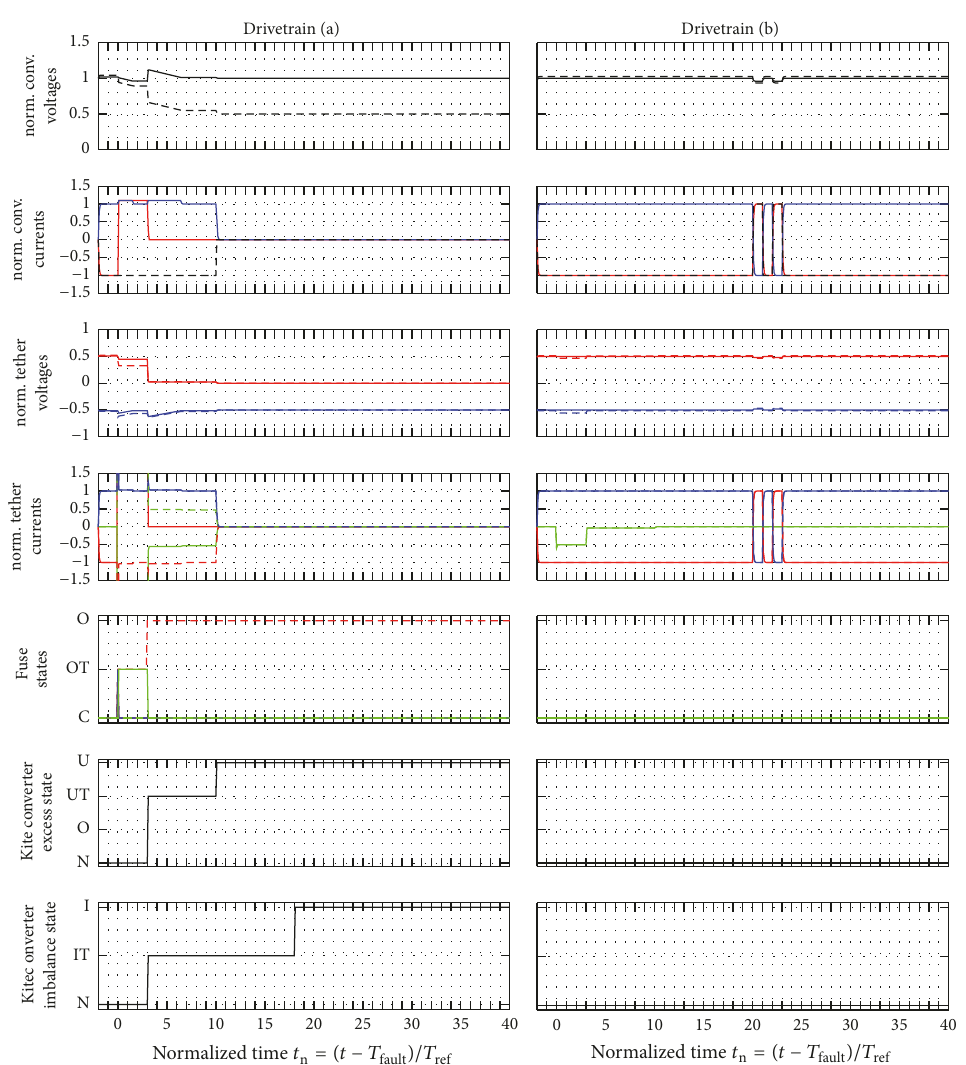
Figure 19: Simulated voltages, currents, and states for short circuit fault S2 in generator mode, with the same colors as in Figure 18.